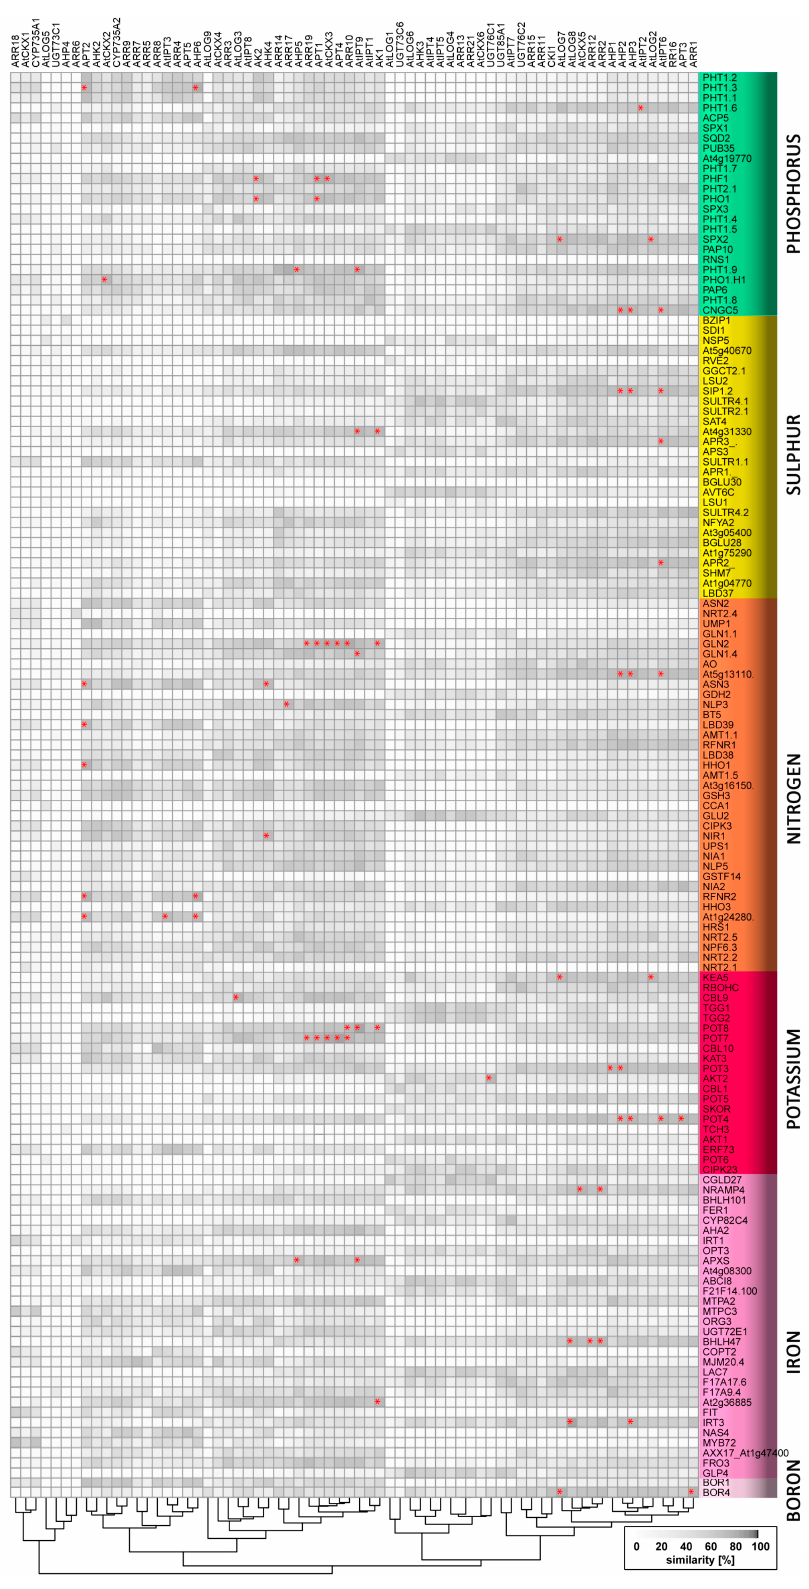
Figure 2. Similarity of expression patterns of genes related to nutrient stress and genes involved in cytokinin metabolism or signalling. Asterisks indicate profile similarities >85%. The heatmap was generated using R software and available data from Araport [33].